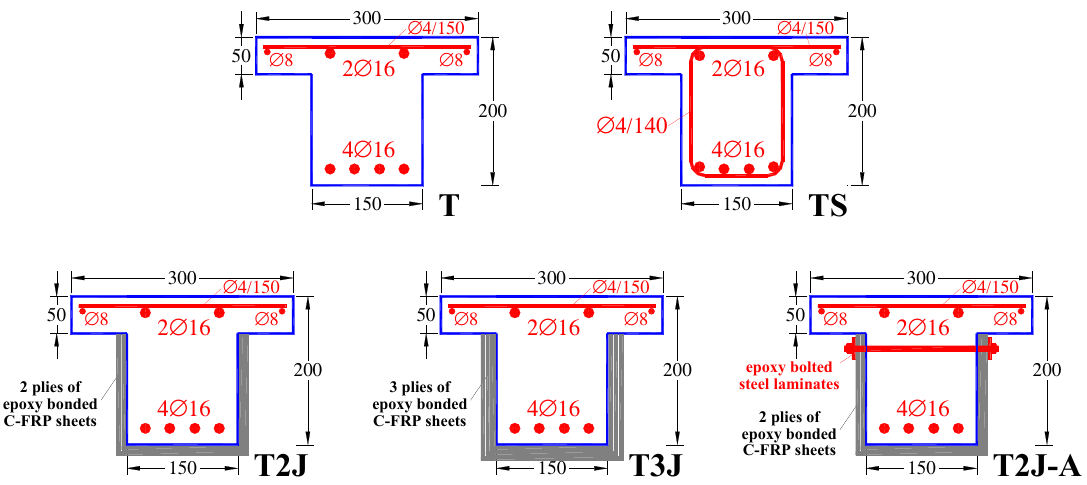
Figure 1. Cross-section dimensions and reinforcement details of the tested beams.